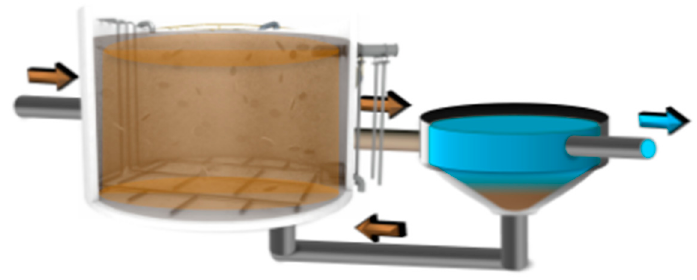
Figure 8. IFAS ANITA Mox